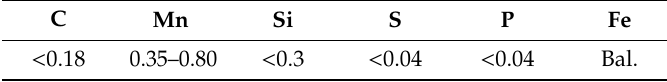
Table 1. Chemical composition (in wt. %) of ASTM A283-C steel.